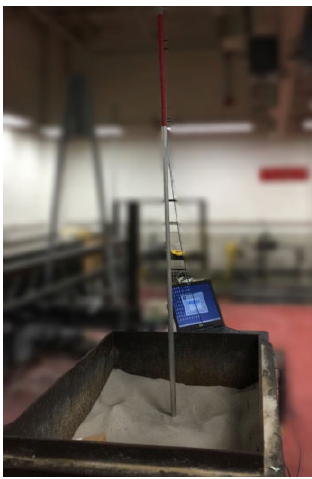
Fig. 6 Indoor experimental